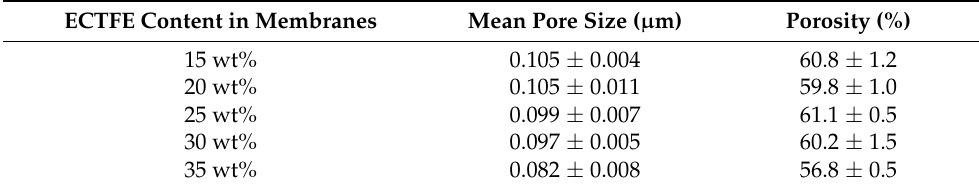
Table 7. Pore size and porosity of prepared ECTFE membranes.